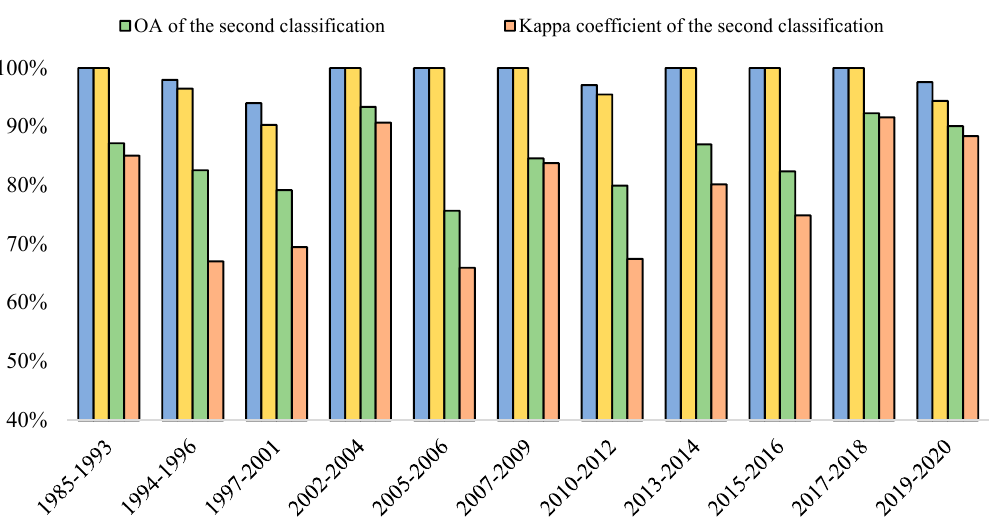
Figure 5. Verification set results of glacier extraction from 1985 to 2020.